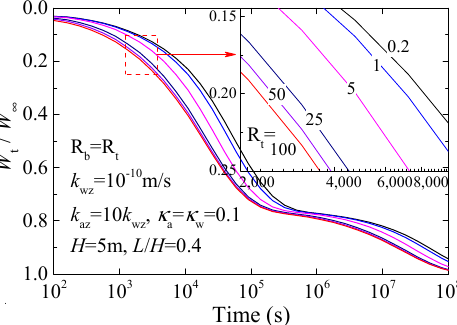
Figure 6. Variations of soil layer settlement under symmetrical vertical impeded drainage boundary